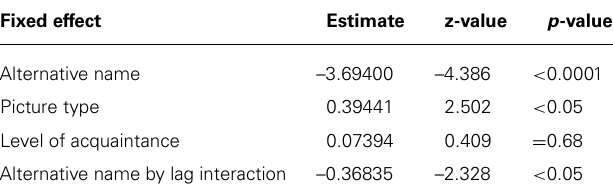
Table 2 | Results from the final statistical